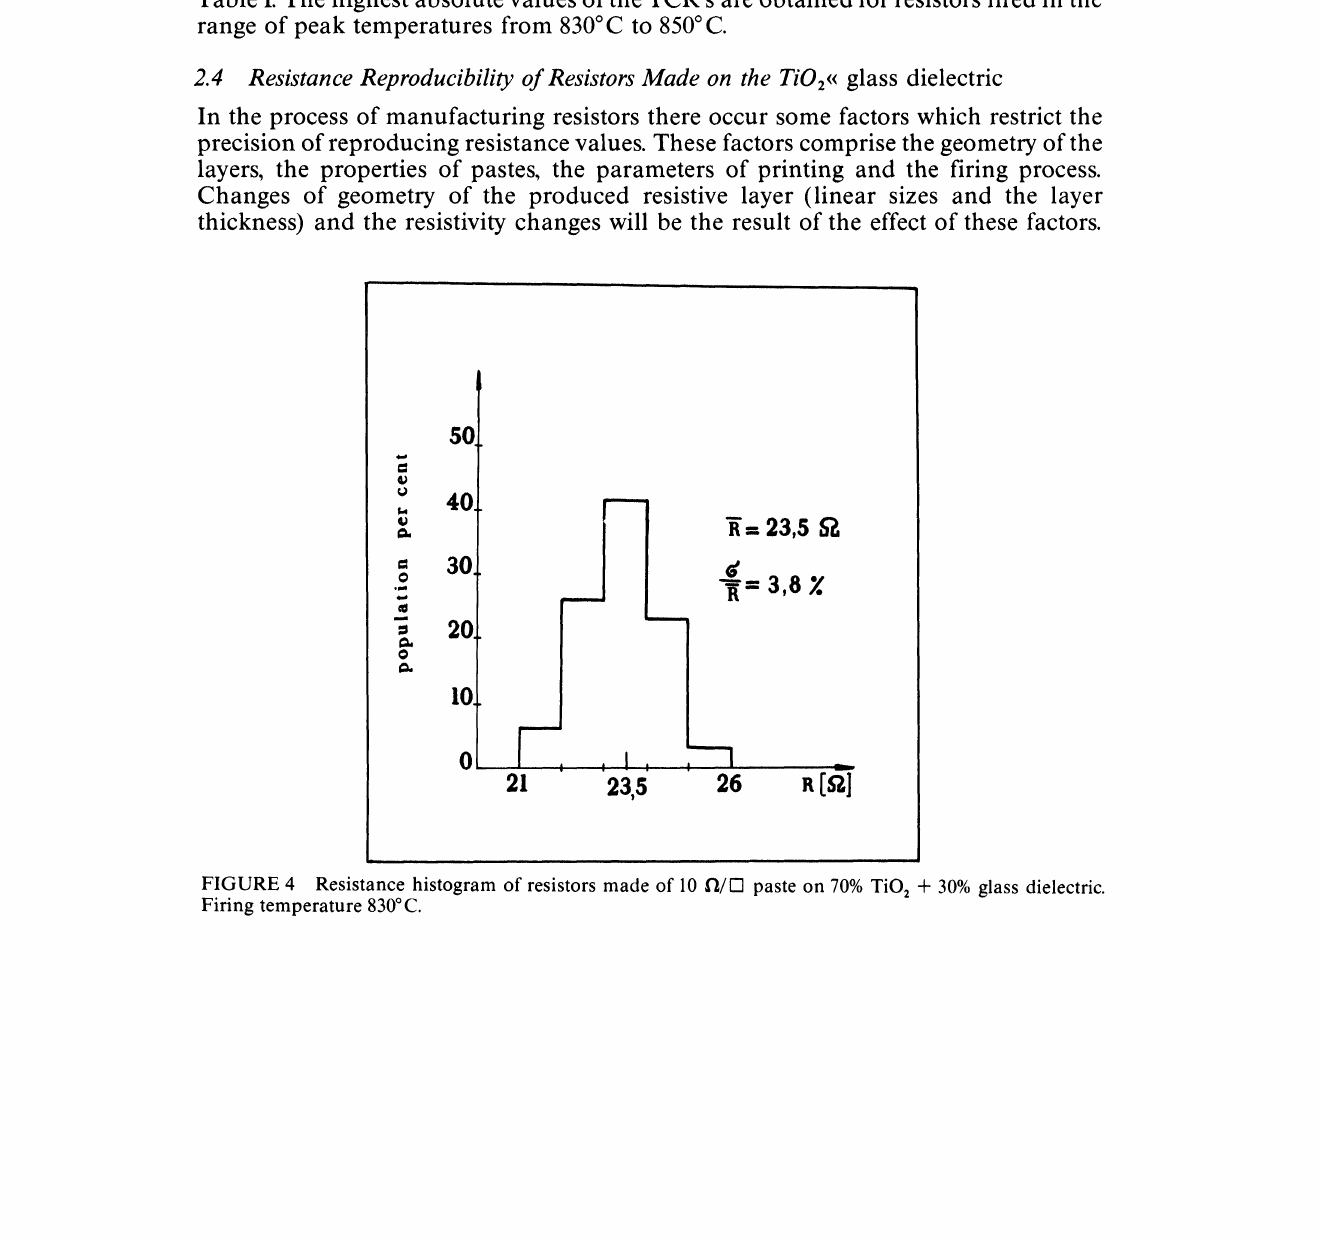
Effect of paste sheet resistivity on resistance and TCR of resistors made on 90% TiO / 10% glass dielectric Sheet resistivity of paste [k/rq]